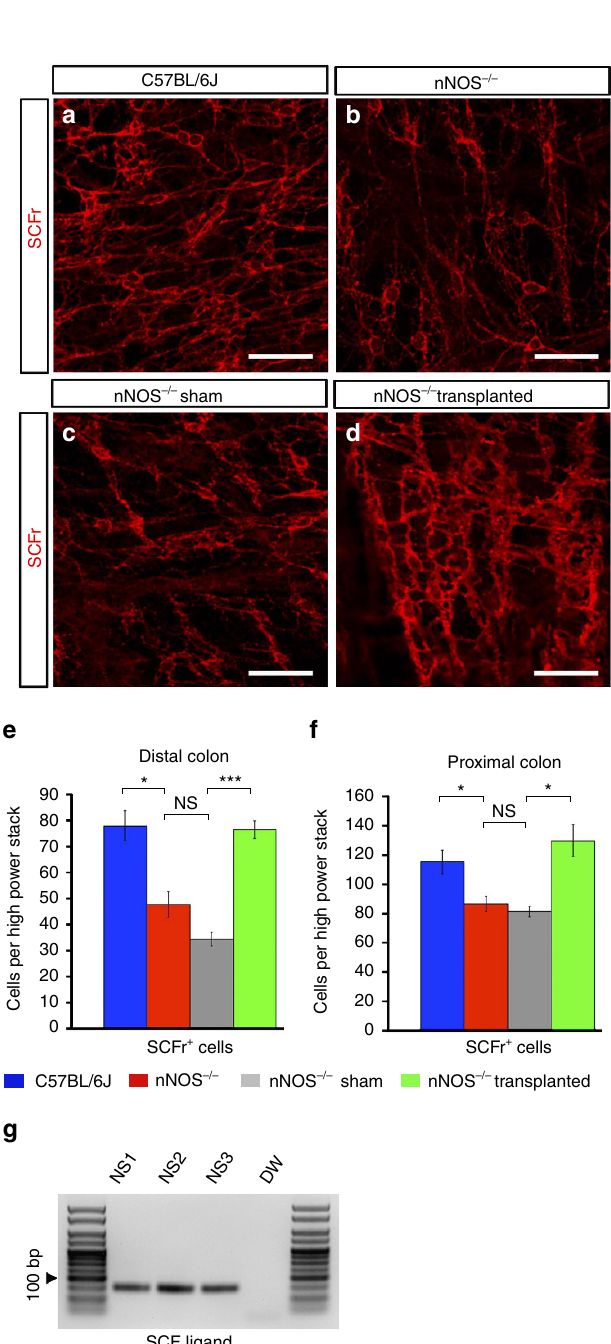
Figure 6 | ENSC transplantation alters ICC networks in nNOS (cid:2) / (cid:2) colon. ( a – d ) Representative z-stack confocal images of ICC in C57BL/6J, nNOS (cid:2) / (cid:2) , sham-operated nNOS (cid:2) / (cid:2) and transplanted nNOS (cid:2) / (cid:2) distal colon. Scale bar, 50 m m. ( e , f ) Quantification of ICC numbers in the distal ( e ) and proximal ( f ) colon in C57BL/6J (blue bars), nNOS (cid:2) / (cid:2) (red bars), sham-operated nNOS (cid:2) / (cid:2) (grey bars) and transplanted nNOS (cid:2) / (cid:2) (green bars) mice calculated as a mean of five high-power stacks per region per mouse. n ¼ 3 for each group. *** P r 0.001, P r 0.05 by Student’s t -test. Error bars represent mean ± s.e.m. in all panels. ( g ) Representative PCR gel demonstrating expression of SCF ligand in Wnt1 cre/ þ ;R26R YFP/YFP -derived neurospheres (NS). Neurosphere cultures were derived from separate Wnt1 cre/ þ ;R26R YFP/YFP intestines ( n ¼ 3). Autoclaved Milli-Q water (DW) was used as a non-template negative